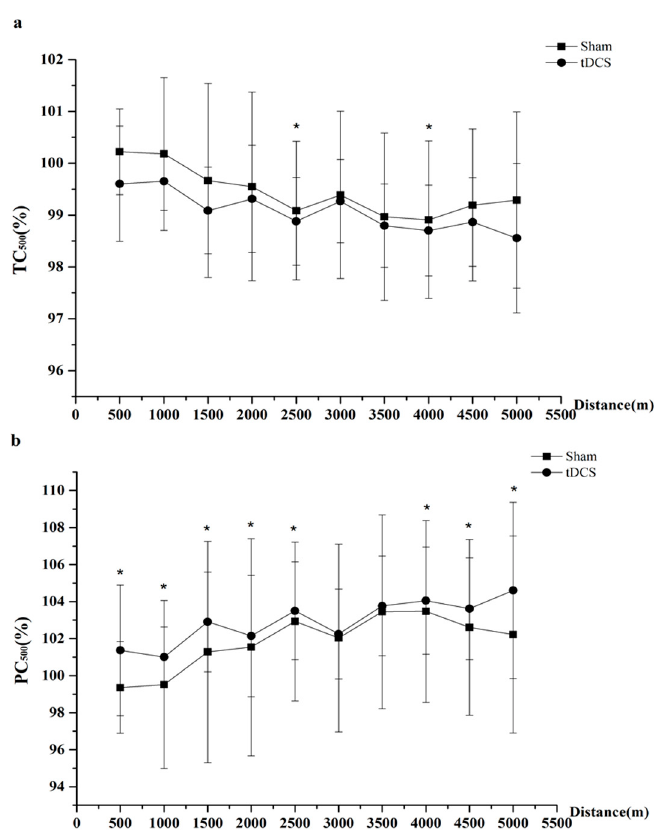
Figure 3. Effect of transcranial direct current stimulation (tDCS) on time corresponding to 500 m (TC500) and power corresponding to 500 m (PC500) during 5 km row. ( a ) is the percent changes in TC500 between tDCS and sham. Significant differences between tDCS and sham were found at 2500 m and 4000 m. ( b ) is the percent changes in PC500 between tDCS and sham. Significant differences between tDCS and sham were found at 500 m, 1000 m, 1500 m, 2000 m, 2500 m, 4000 m, 4500 m and 5000 m.